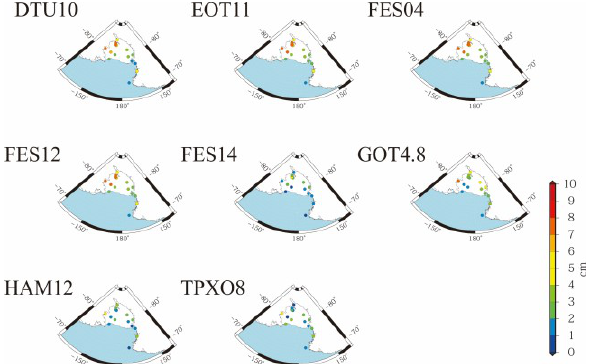
Figure 8. The same with Figure 6 but for Ross ice shelf region. It shows a clear pattern that the vector differences increase with latitude increase. Figure 7. The same with Figure 6 but for Amery ice shelf Region. All calculated vector differences on the ice shelf are Table 5. The same with Table 3, but for Ross ice shelf under 5 cm. Table 4. The same with Table 3, but for Amery ice shelf